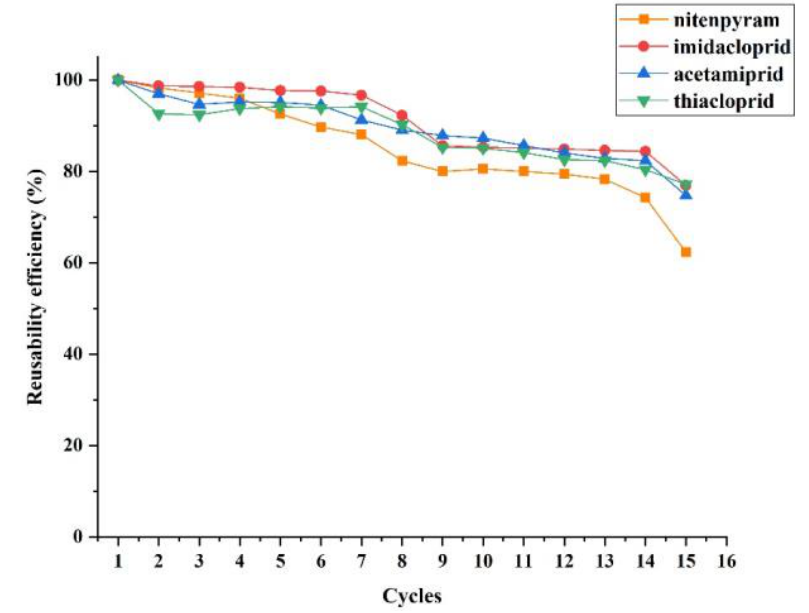
Figure 8. Reusability of the MIL-53 MMM for DME. Table 2. Intra-day and inter-day precision (RSDs, %) for the MOF membrane extraction-HPLC method for the determination of four neonicotinoid